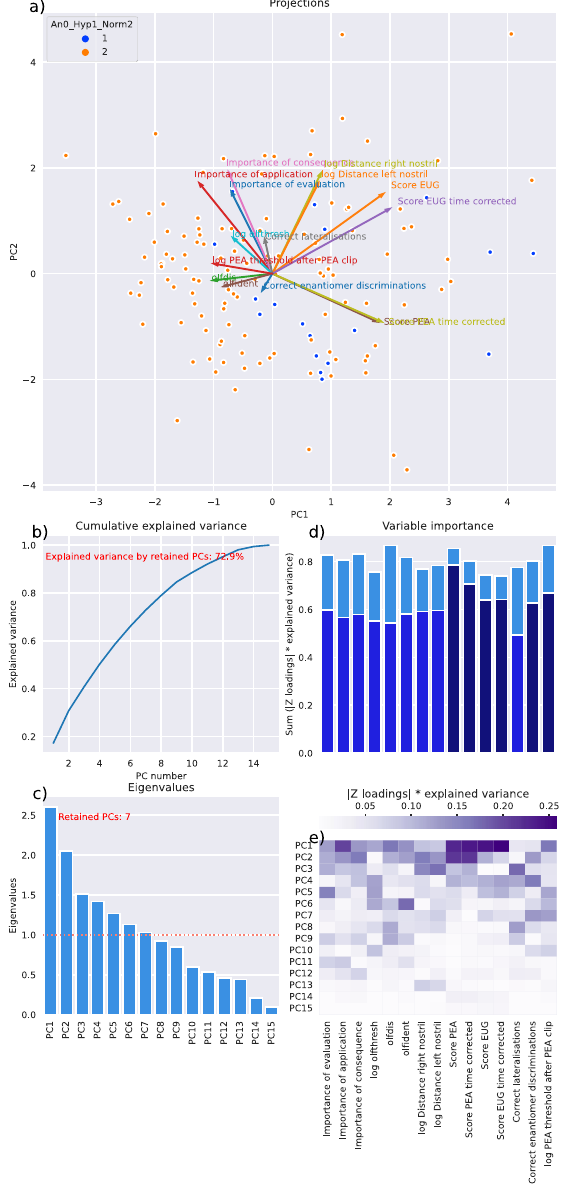
Figure 4. Results of a principal component analysis (PCA)-based projection of centered and standardized olfaction-related data. ( a ) Projection of olfactory data collected in d = 15 olfactory variables from n = 135 subjects onto the first two principal component levels. Data points originating from subjects with normosmia or hyposmia are colored red and blue, respectively. ( b ) Line plot of cu- mulative explained variance with increasing number of principal components (PCs). ( c ) Bar graph